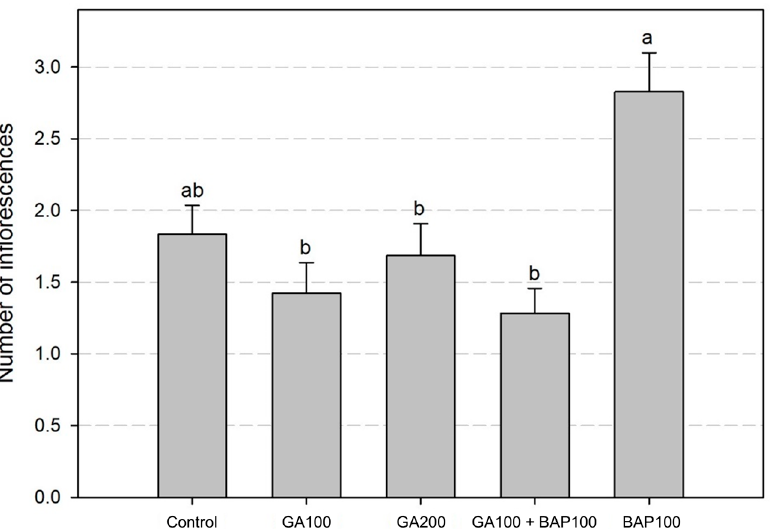
Figure 4. Number of inflorescences of Phalaenopsis Queen Beer ‘Mantefon’ plants treated with exogenous gibberellic acid 3 (GA 3 ) and 6-benzylaminopurine (BAP) at 20 ◦ C forcing temperature for 15 weeks. Control: no hormones; GA100: GA 3 100 mg/L; GA200: GA 3 200 mg/L; GA100 + BAP100: GA 3 100 mg/L + BAP 100 mg/L; BAP100: BAP 100 mg/L. Different letters above bars are considered